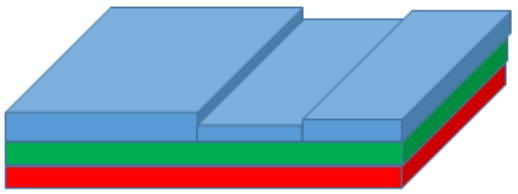
Figure 6. Geometry of simulated part being grounded.